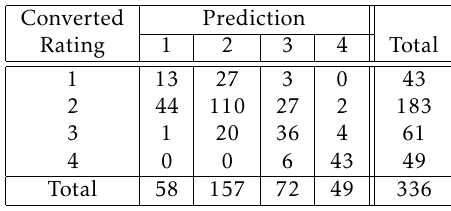
Figure 6. An example of a modified scale which considers CRCs in Figure 5. Table 3. Prediction performance for ”Pleasant”